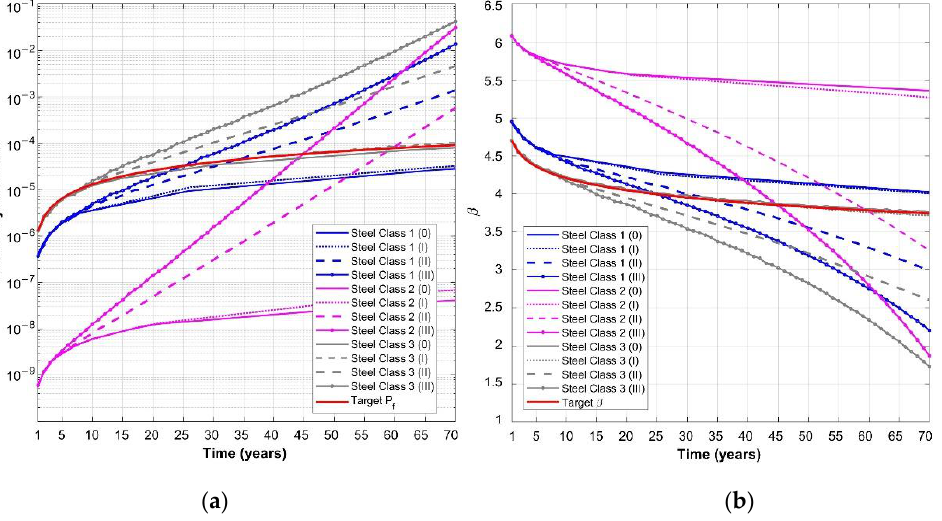
Figure 11. Time-dependent probability of failure ( a ) and reliability index 𝛽 ( b ) for storage building (concrete class 3).